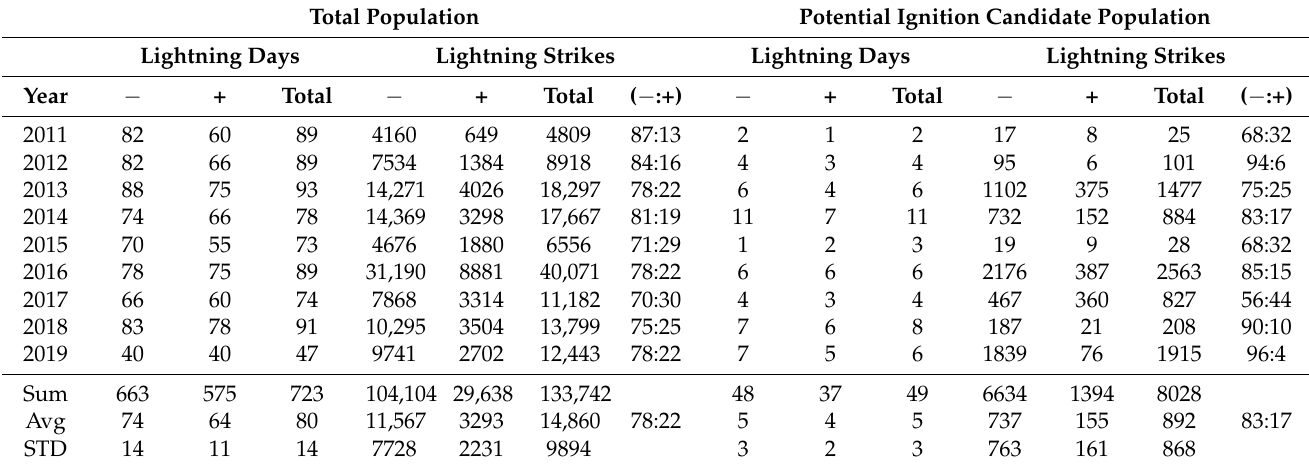
Table 1. Annual total population and potential ignition candidate population of negative and positive of cloud-to-ground (CG) lightning strikes and lightning days for the study period across Tasmania.